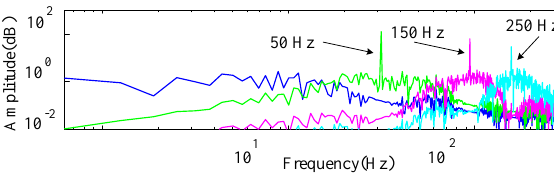
Figure 12. Spectrums of VMD-HT algorithm under K = 4 under noise situation.